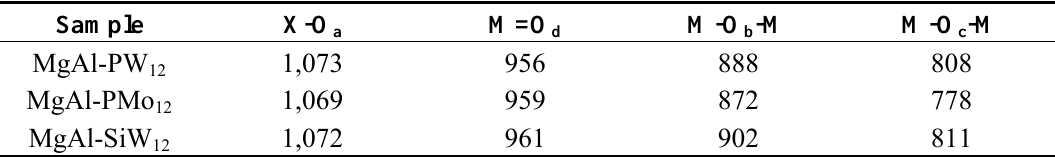
Table 1. IR spectra band of HPA-HTLcs (cm − 1